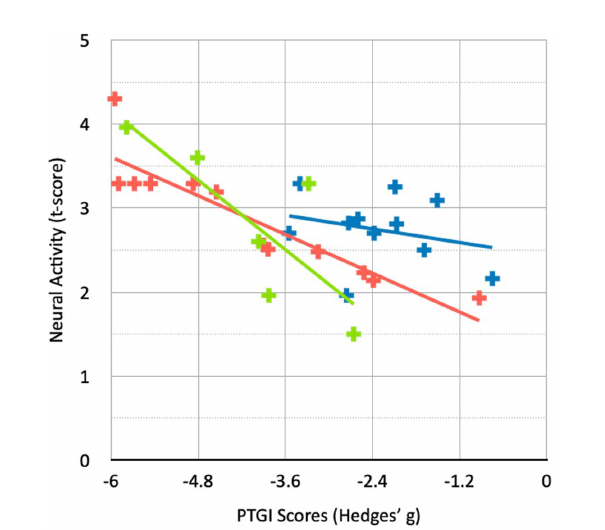
FIGURE 5 Linear regression of T -Scores and Hedges’ g values from ALE meta- analysis. Green markers represent coordinates for CPT. Red markers represent coordinates for EMDR. Blue markers represent coordinates for